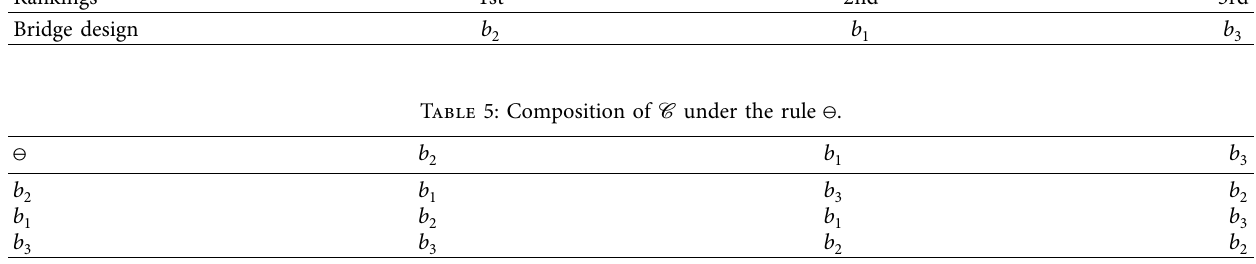
Table 6: LDFNs B i s along with scores, accuracies and rankings on